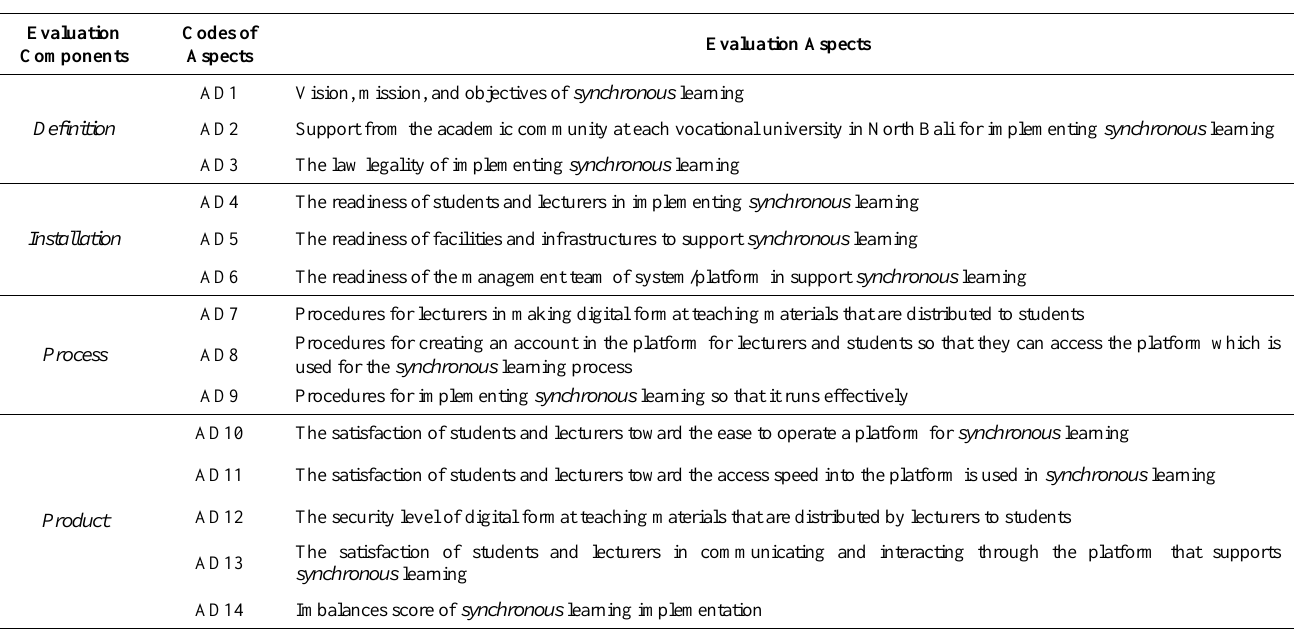
Table 2. Components and Aspects of the Discrepancy Evaluation Model as References for Evaluating the Implementation of Synchronous Learning at Vocational Universities in North